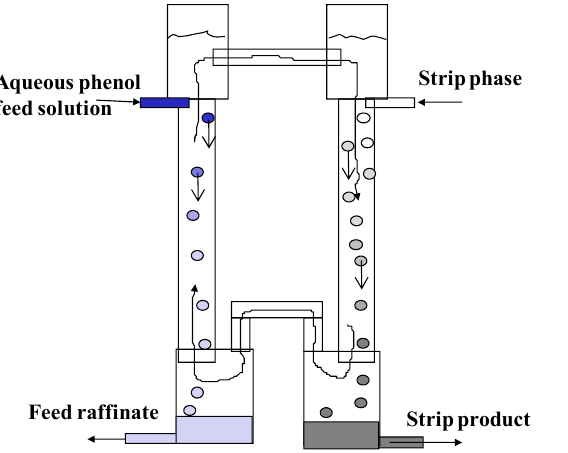
Figure 4. Schematic arrangement of the experimental small three-phase extraction apparatus. The columns were equipped with bottom settlers (diameter 50 mm) and upper sepa- rating zones (diameter 40 mm). A schematic diagram of a large three-phase extractor is shown in Figure 5.